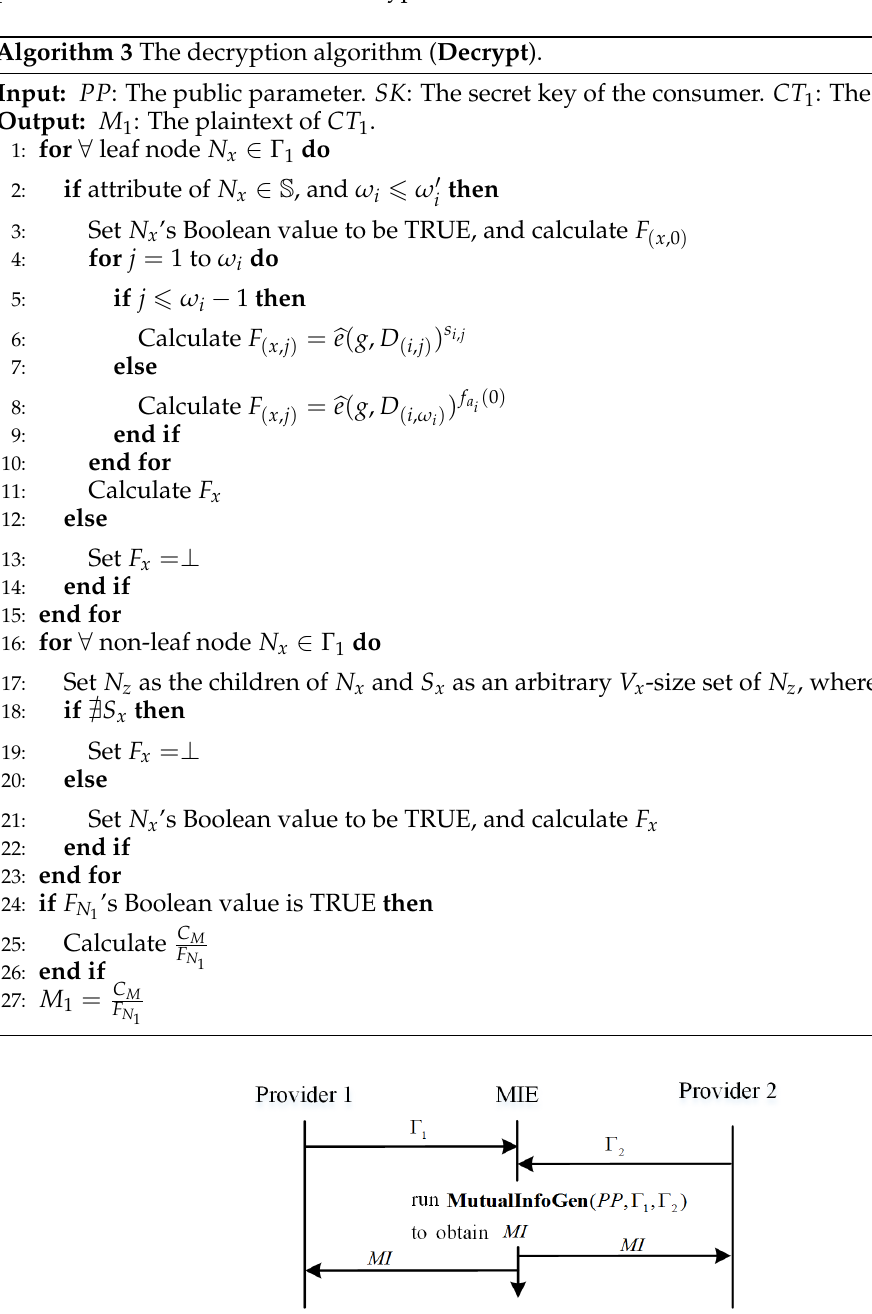
Algorithm 3 The decryption algorithm ( Decrypt ).